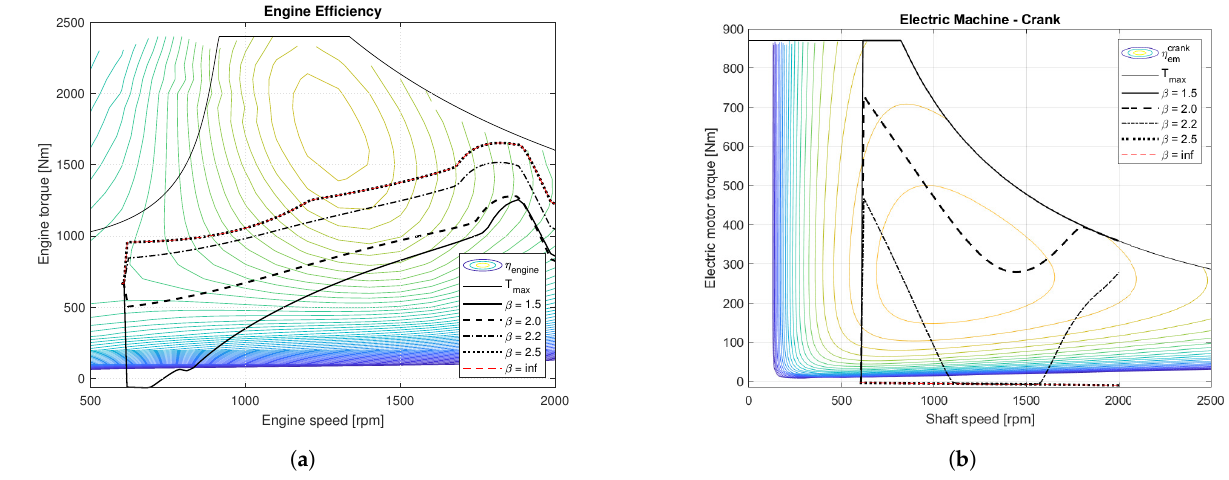
Figure 9. Solution characteristics when using a combustion engine and a crank shaft electric motor. The legends display the cost factors ( β ) for the different solutions. ( a ) Diesel engine utilization during a fuel optimal acceleration with E-crank. ( b ) Utilization of the E-crank during the acceleration. When β = inf, the electric motor torque is negative due to friction.